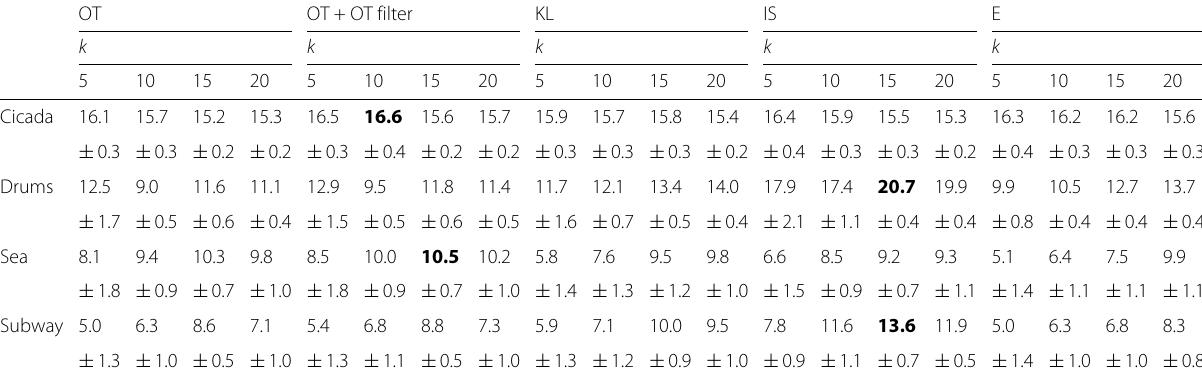
Table 3 Speech denoising SAR scores